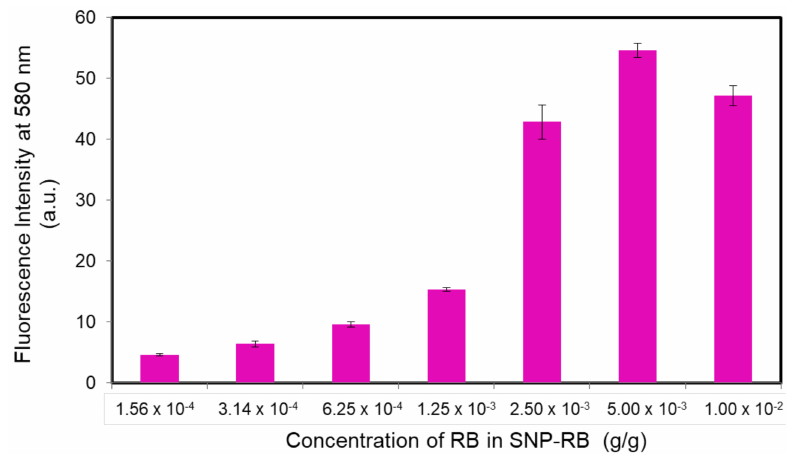
Figure 2. Correlation between maximum fluorescence intensity at 580 nm vs. Rhodamine B concen- tration in SNP-RB samples. The error bars were obtained after three separate experiments.